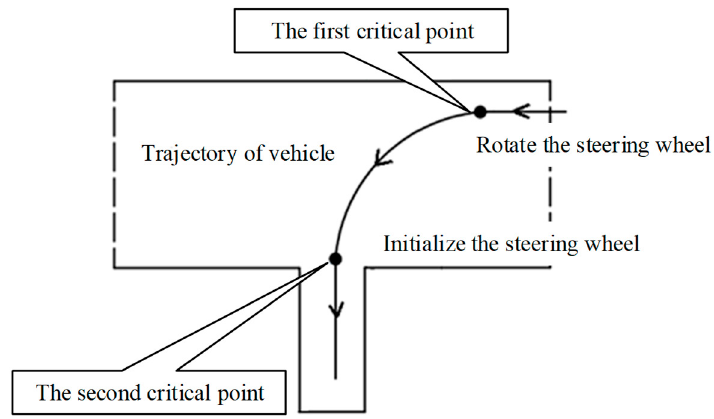
Figure 10. The process of reverse parking.